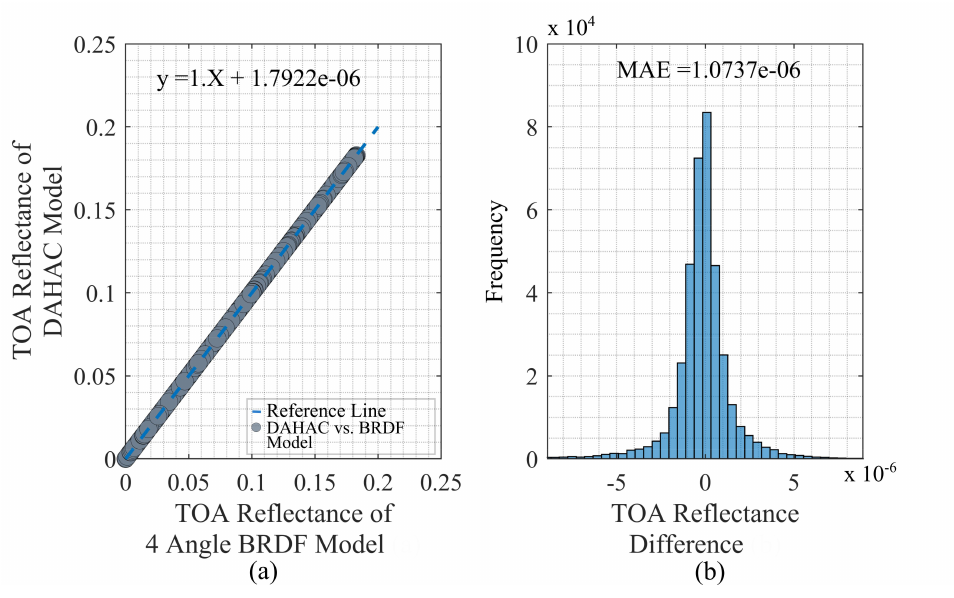
Figure 19. Showing ( a ) TOA reflectance of 4-angle hyperspectral BRDF model (15 coefficients) vs. DAHAC model (7 coefficients) and ( b ) histogram with TOA reflectance difference between 4-angle hyperspectral BRDF model vs. DAHAC model TOA